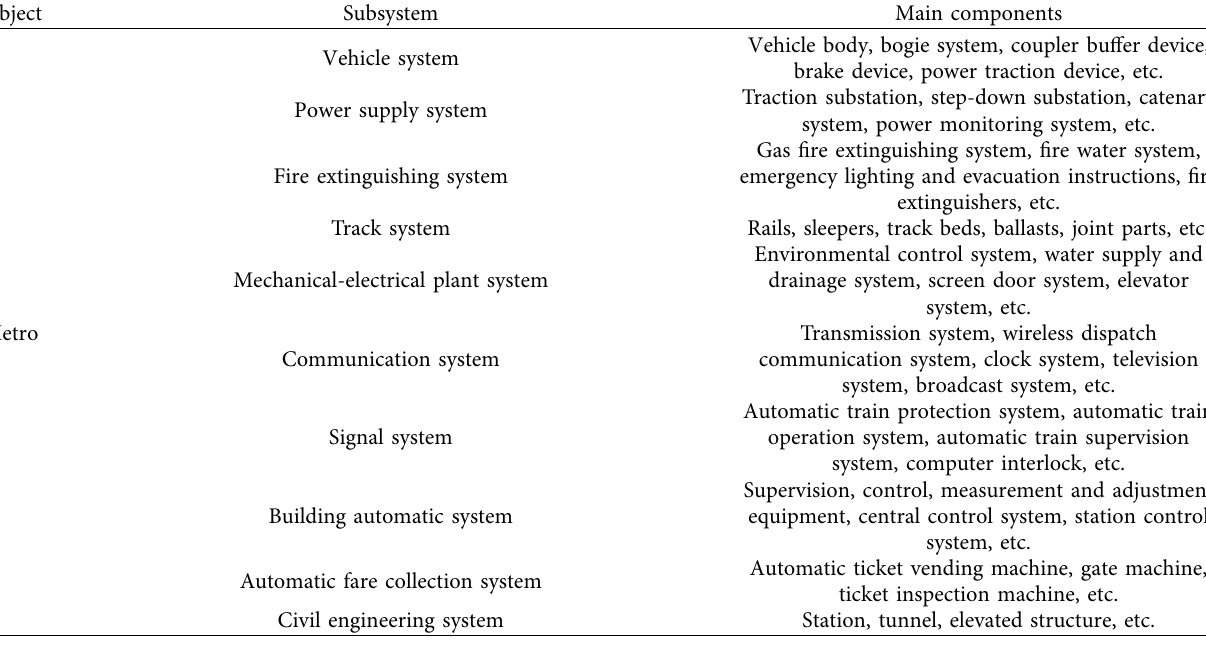
Table 4: Subsystems and components.